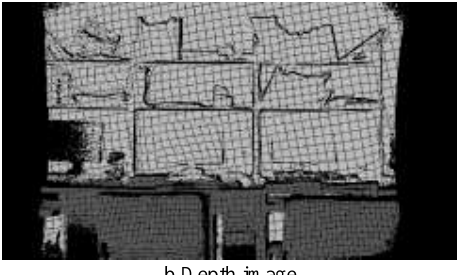
Figure1 Color image and depth